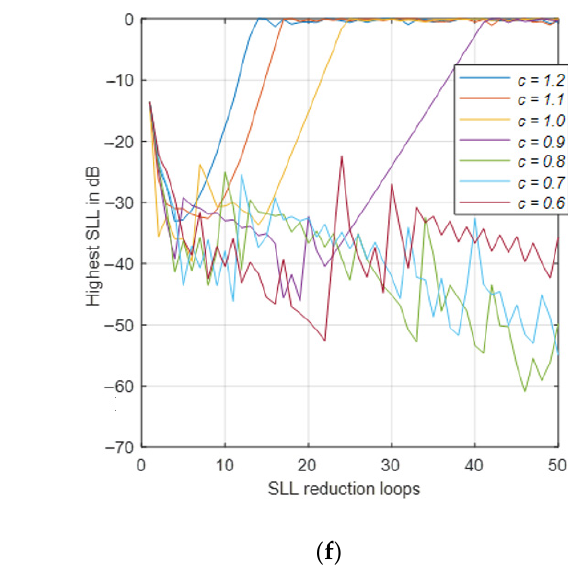
Figure 2. Convergence profile of the conventional SSR learning curves at different damping factor values and array sizes of: ( a ) 16 elements, ( b ) 32 elements, ( c ) 64 elements, ( d ) 128 elements, ( e ) 256 elements, and ( f ) 512 elements.